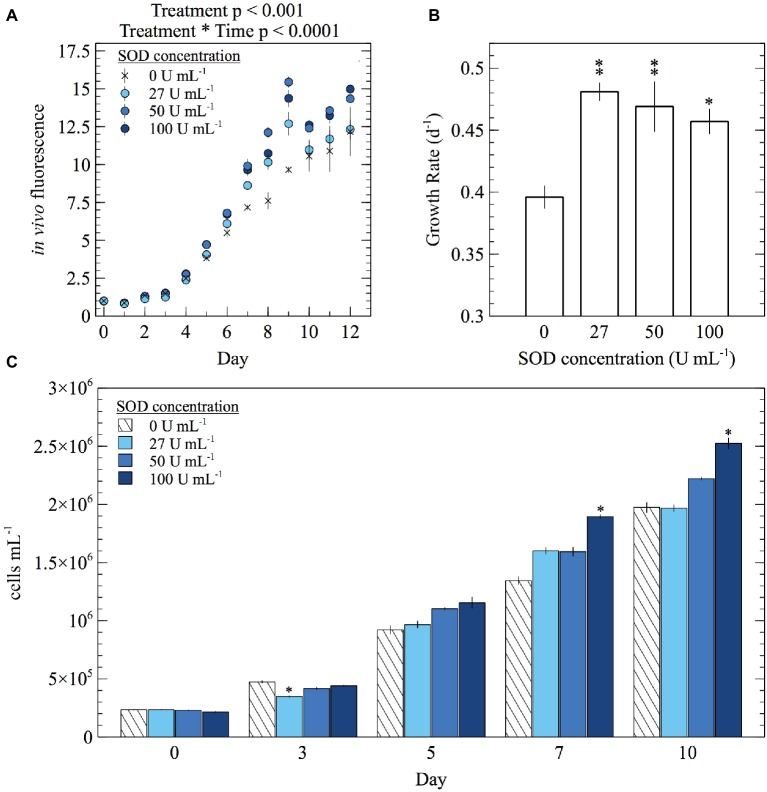
The effect of daily SOD additions on (A) average in vivo fluorescence, (B) specific growth rate during exponential growth phase, and (C) cell abundance of E. huxleyi. Significant differences in in vivo fluorescence between SOD additions were found using a mixed factor repeated measures ANOVA. Significant differences (two sample Student’s t-test) in specific growth rate and cell abundances relative to the control (0 U ml−1 SOD) are indicated by asterisks, where p < 0.05 and < 0.01 are represented by * and ** symbols, respectively. Error bars depict one standard error of the mean of biological replicates (n = 3).